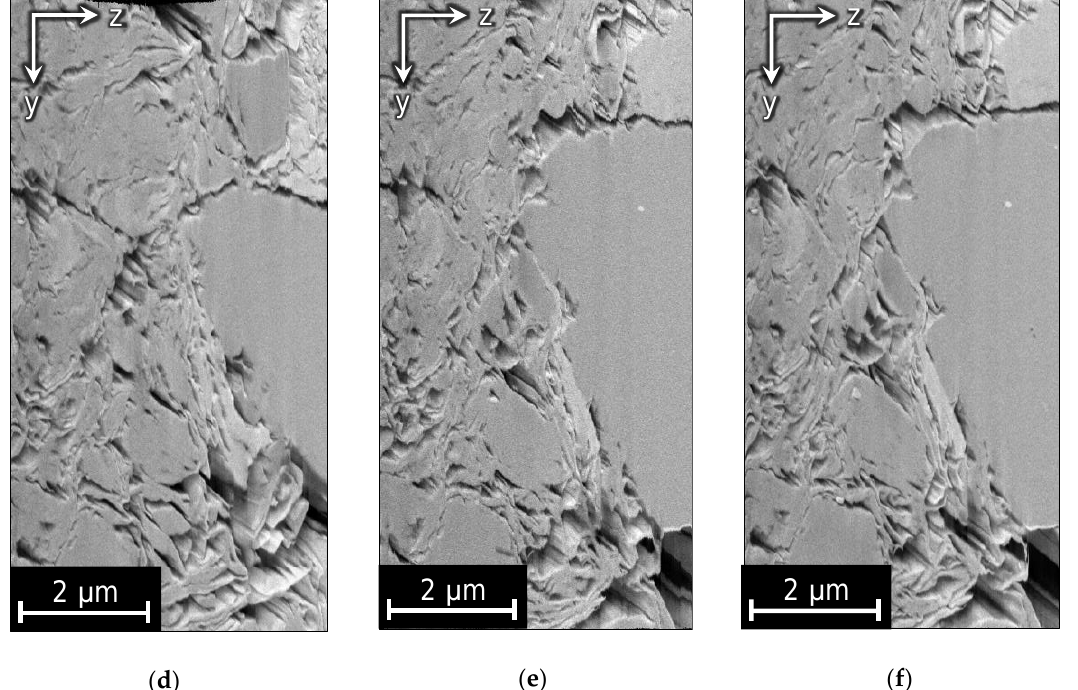
Figure 15. The side view for sample A: ( a ) the original image; ( b ) aligned with StackReg; ( c ) aligned with ImageStabilizer; ( d ) aligned with JavaSIFT; ( e ) aligned with Elastic; ( f ) aligned with the proposed algorithm.